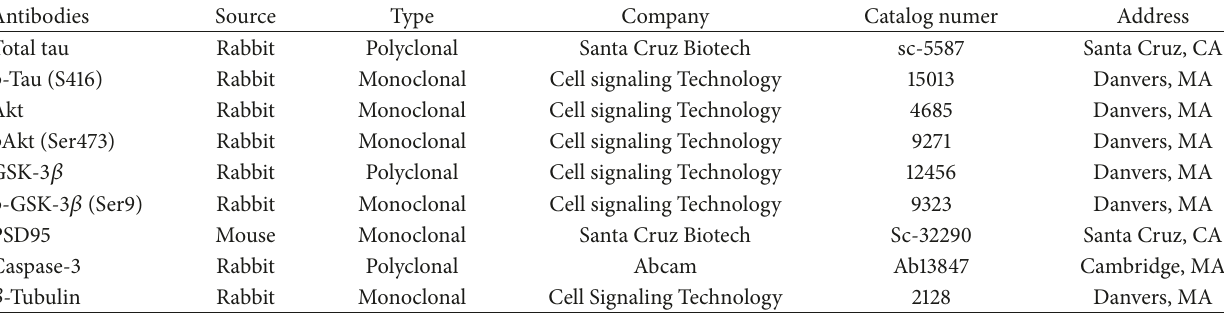
Table 1: Sources of different antibodies used in this